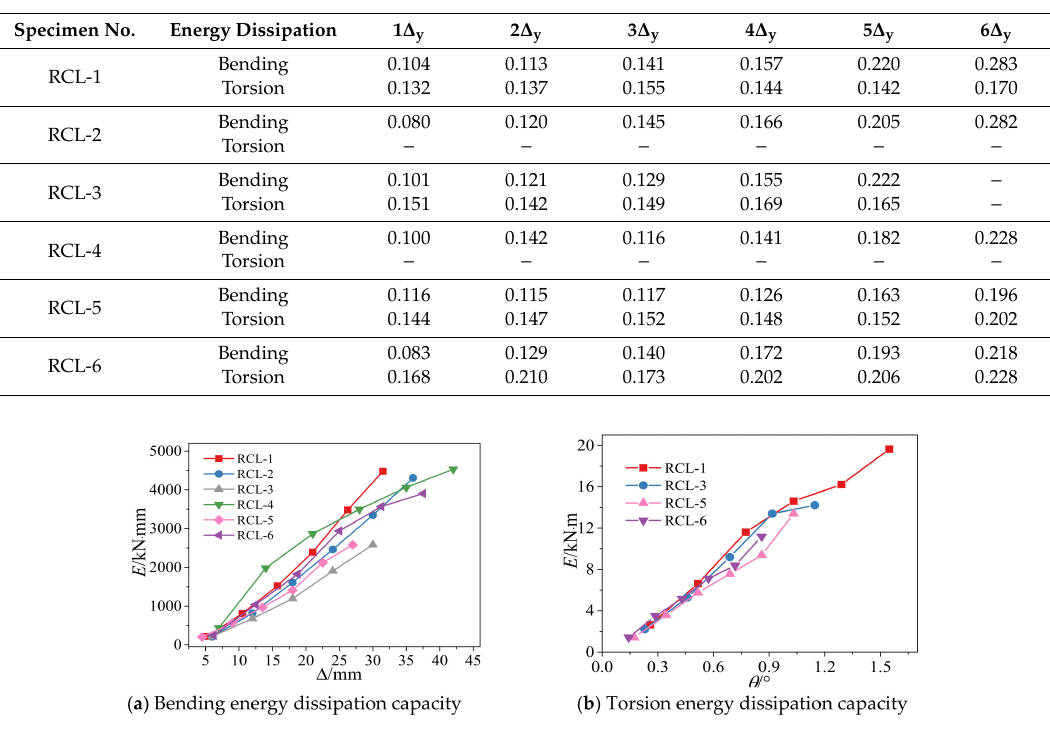
Table 3. Equivalent damping ratio of specimens.